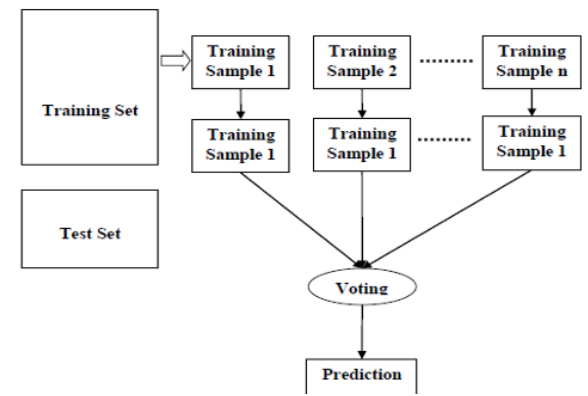
Figure 6. Phases in a Random Forest